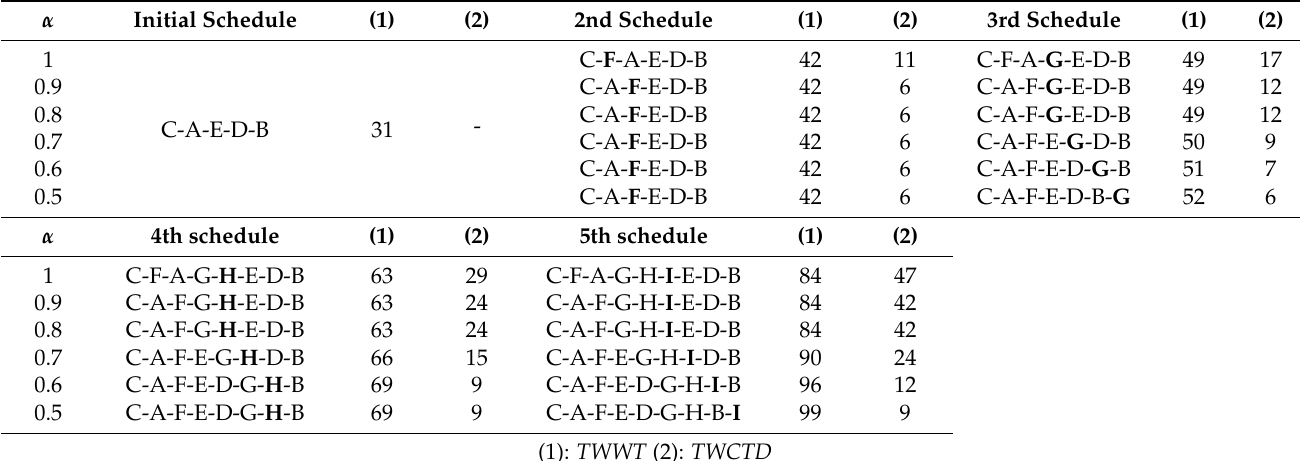
Table 8. The first five jobs disposition.